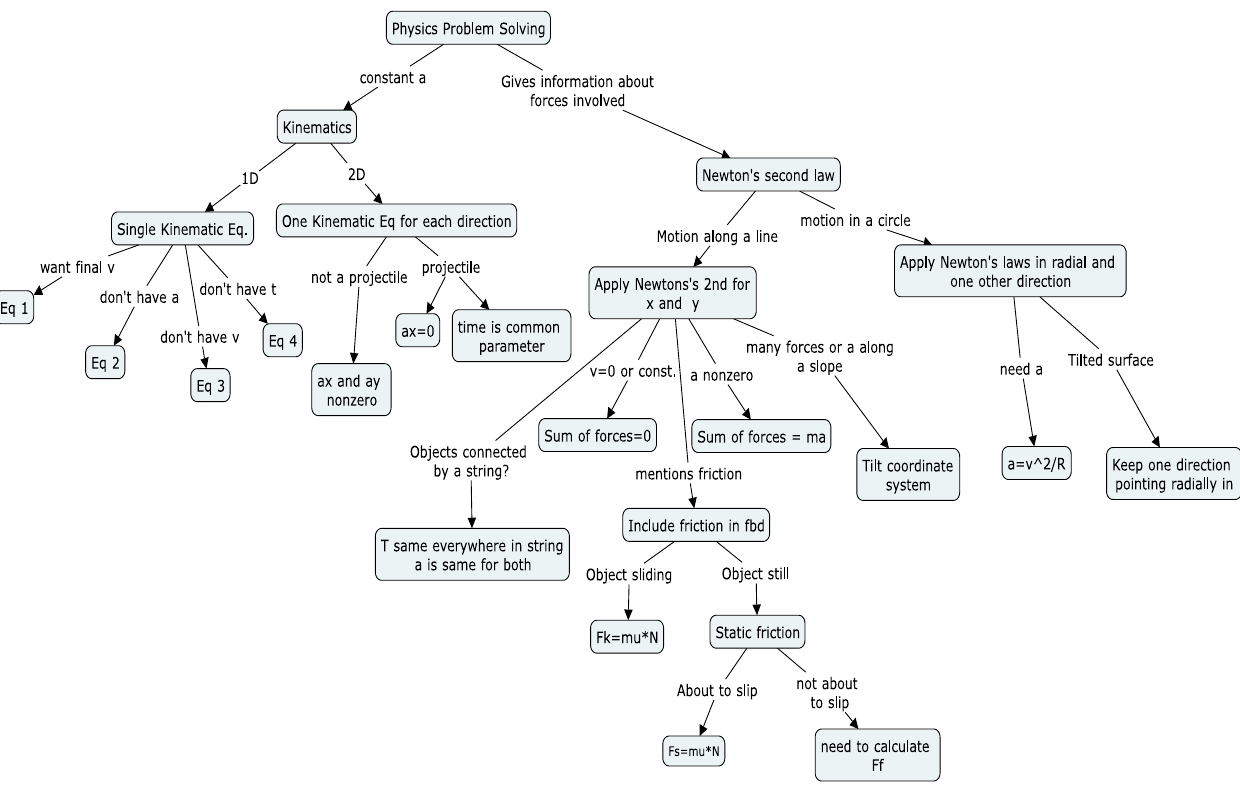
FIG. 1. Example problem-solving strategy map generated at the end of the units on 1D kinematics, 2D kinematics, and Newton ’ s laws. The instructor created this map and shared it with the students to demonstrate the intended